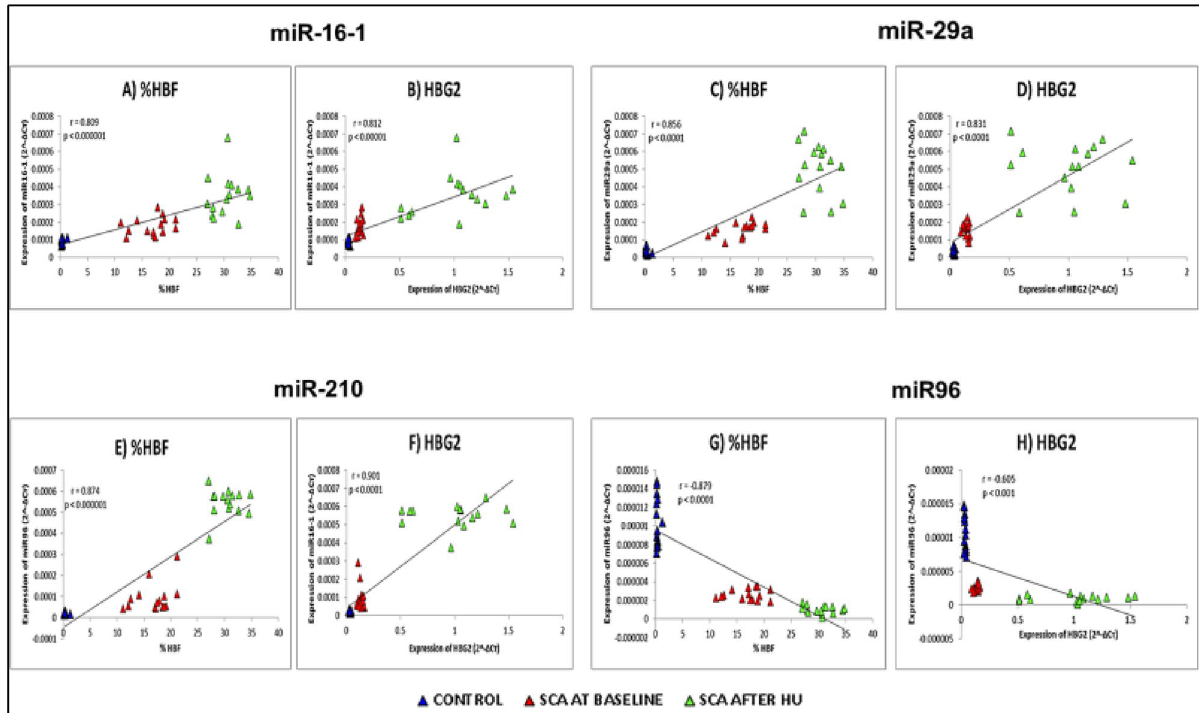
Figure 3. Spearman’s correlation analysis. Correlation of miRNA (miR-16-1, miR-29a, miR-210 and miR-96) with HbF levels and HBG2 expression. Correlation of miR16-1 and miR-29a expression in paired samples (baseline and after 3/6 months {SCD/HU} of HU therapy) with ( A & C ) HbF levels ( B & D ) HBG2 expression. Correlation of miR-210 and miR-96, expression in paired samples (baseline and after 3/6 months {SCD/HU} of HU therapy) with HbF levels ( E & G ) and HBG2 expression ( F & H